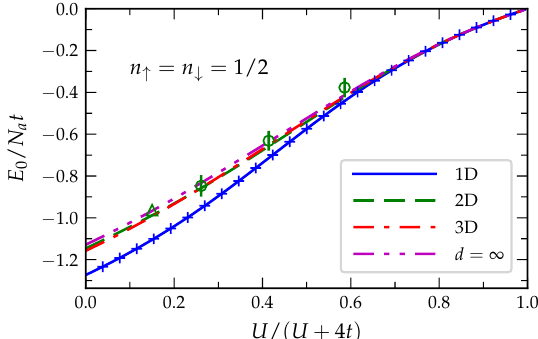
Figure 7. Ground-state energy of the half-filled Hubbard model on periodic hypercubic d -dimensional lattices as function of the Coulomb-repulsion strength U / t . All curves were obtained by means of the linear independent-Fermion entropy (IFE) approximation to LDFT. The exact ground-state energy of the 1D lattice is given by the blue crosses [84]. The green triangles and circles correspond to quantum Monte Carlo simulations for the 2D square lattice [85,86]. For each dimension d , the NN hopping integral t d is scaled as t d = t / √ d in order that the second moment w 2 = 2 dt 2 states is the same for all d . Reproduced with permission from Reference [72]. c (cid:13) American Physical